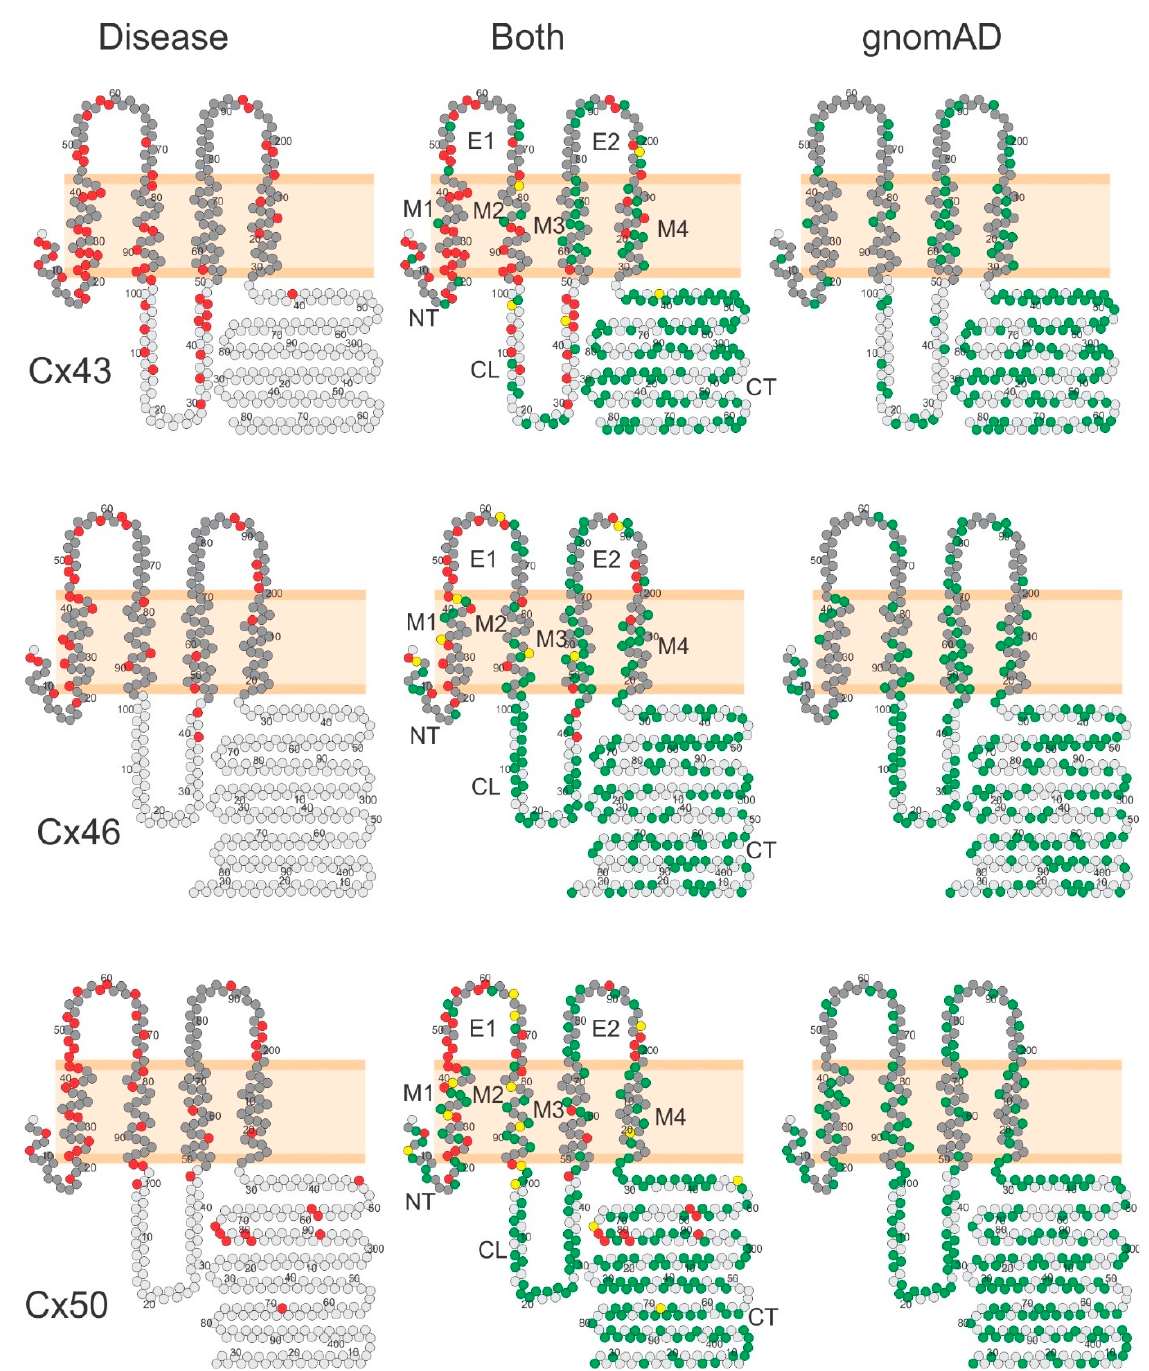
Figure 4. Disease-linked and gnomAD-linked missense variants on topological structure models. Topological structure models for human Cx43, Cx46, and Cx50 are shown. The residues corresponding to structure-resolved (dark gray) or structure-unresolved residues (light gray) are indicated. Left panels illustrate the disease-linked missense variant residues in red, and the right panels display the gnomAD-linked missense variant residues in green. The middle panels illustrate both disease-linked missense variants and gnomAD-linked missense variants (the overlapped residues are colored in yel- low). Among these overlapped positions, most of the disease-linked missense variants (22/26) were different amino acid substitutions from those found in gnomAD. The differential distribution patterns are discussed below. Note some residue positions can have two or more unique missense variants.